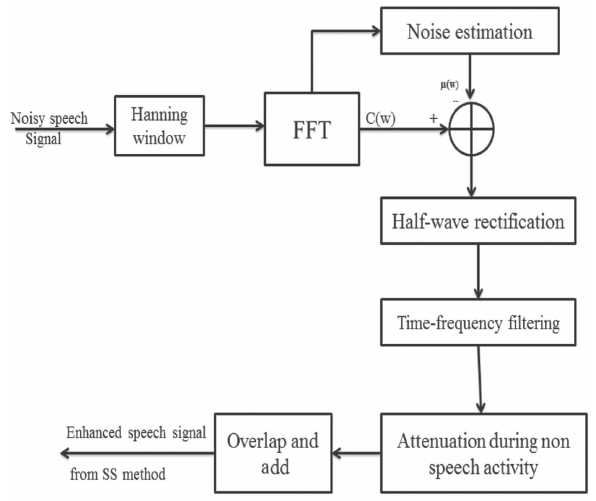
Figure 3: Block Diagram of SS-VAD